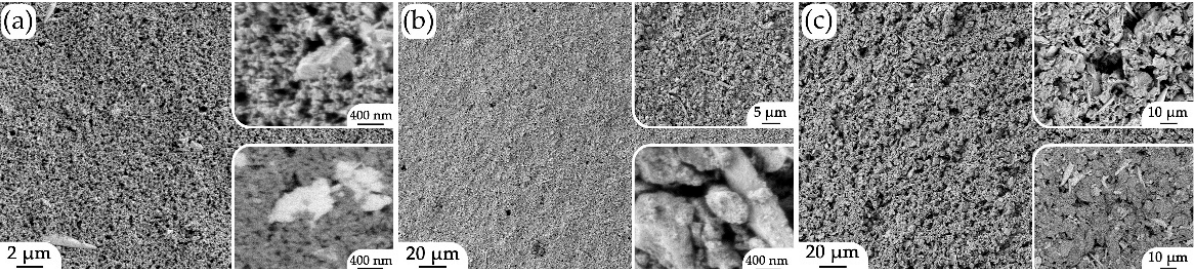
Figure 4. Surface microstructure of single- ( a ), two- ( b ) and three-layer ( c ) coatings deposited sequentially on an Al 2 O 3 substrate: ( a ) NiO-SDC (top inset—secondary electron detector; bottom inset—reflected electron detector); ( b ) (NiO-SDC)/SDC; ( c ) (NiO-SDC)/SDC/(LSCF-SDC) (top inset—secondary electron detector; bottom inset—reflected electron detector).